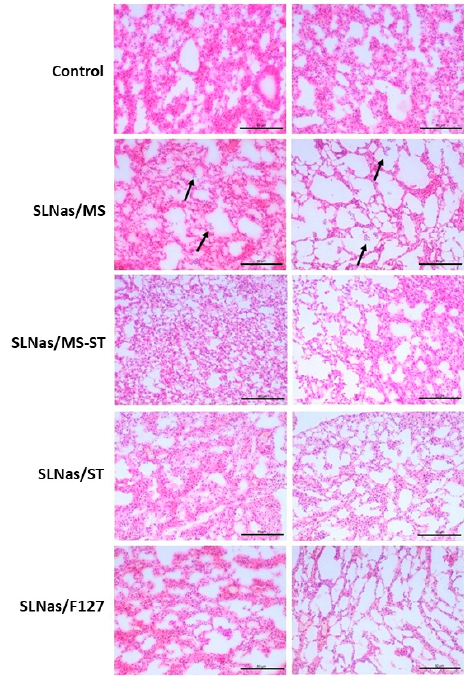
Figure 6. Histological sections of the medial (left panel) and inferior portion (right panel) of control mice lungs in comparison with lungs at 24 h post-exposure to SLNas / MS, SLNas / MS-ST, SLNas / ST, and SLNas / F127. Arrows indicate mild neutrophilic infiltration. Slides were stained using H&E. Magnification: 20 × . Scale bars = 80 µ m.